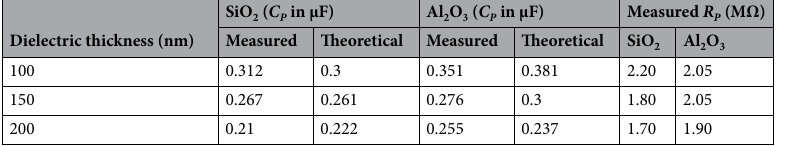
Table 2. Measured and theoretical capacitance ( C P ) and measured resistances ( R P ) of three different dielectric thicknesses of Al